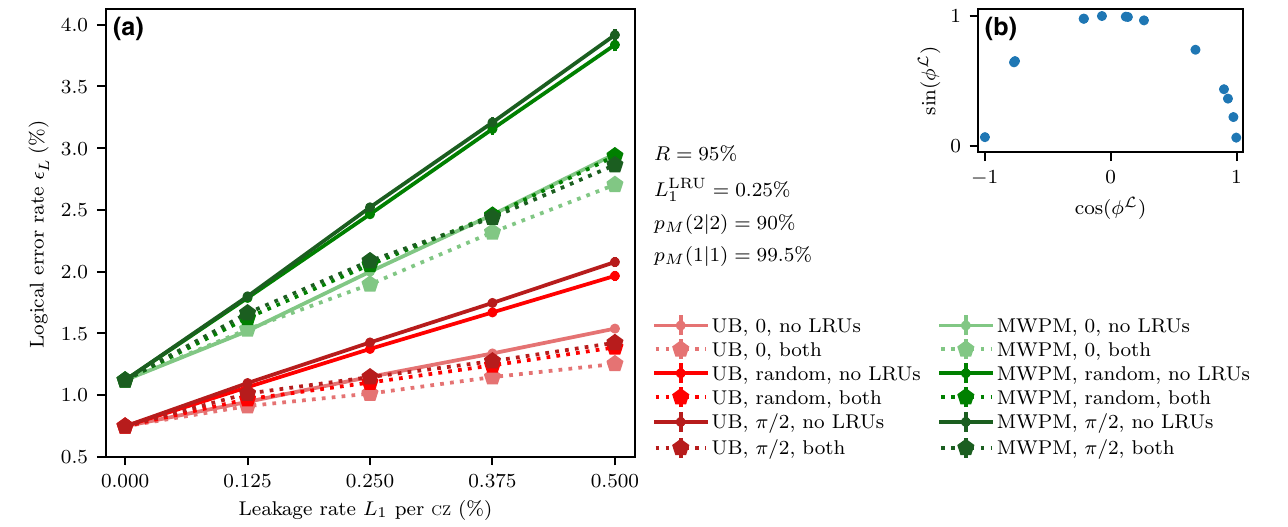
FIG. 10. Variation of the logical error rate ε L for different choices of leakage conditional phases φ L . (a) The logical error rate ε L per QEC cycle for the UB (shades of red) and MWPM (shades of green) decoders versus L 1 , in the cases with no LRUs and both LRUs, each for all φ L set to 0, π/ 2, or uniformly random in [0, π ]. These results are extracted from 2 × 10 4 runs of 20 QEC cycles each per choice of parameters. Error bars are estimated using bootstrapping and are mostly smaller than the symbol size. (b) The random values for φ L used across this work. These values are extracted from a uniform distribution in [0, π ]. We have excluded negative values as ± φ L corresponds to the same chance of spreading a Z error under the twirling action of the parity-check